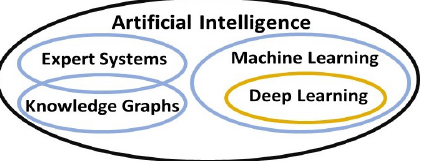
Figure 1. Although often used synonymously, deep learning is only a subfield of AI. The latter also includes other promising techniques for smart manufacturing, such as knowledge